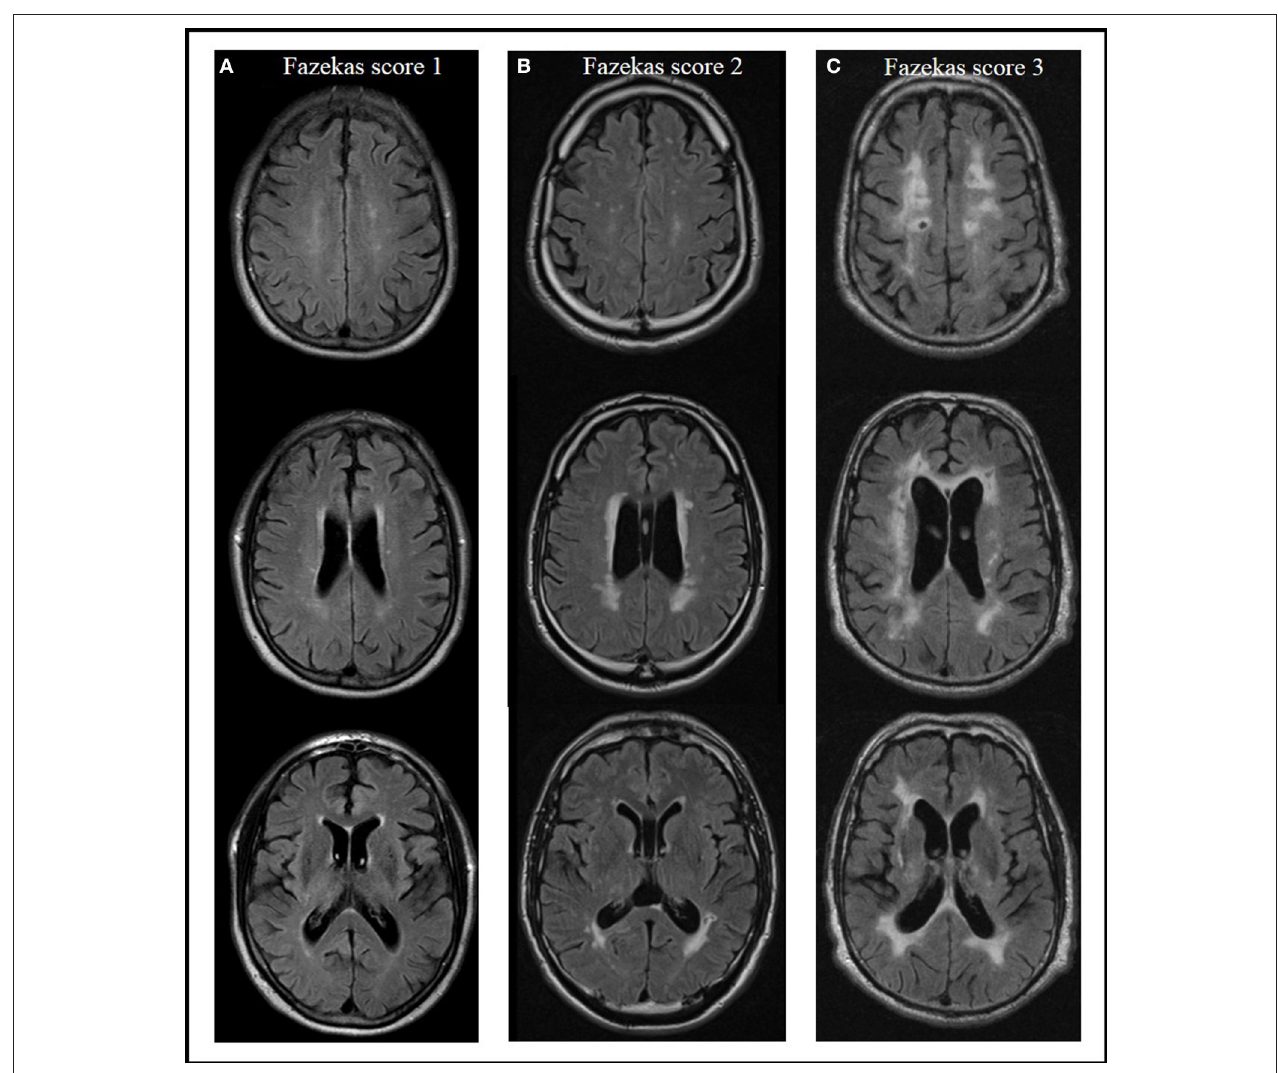
FIGURE 1 | Presence and severity of white matter changes in MRI according to the Fazekas score, examples from the actual evaluation. Score 1 (mild) with focal or punctuate lesions (A) ; score 2 (moderate) with beginning confluent lesions (B) ; score 3 (severe) with confluent lesions (C) (Prins and Scheltens, 2015).